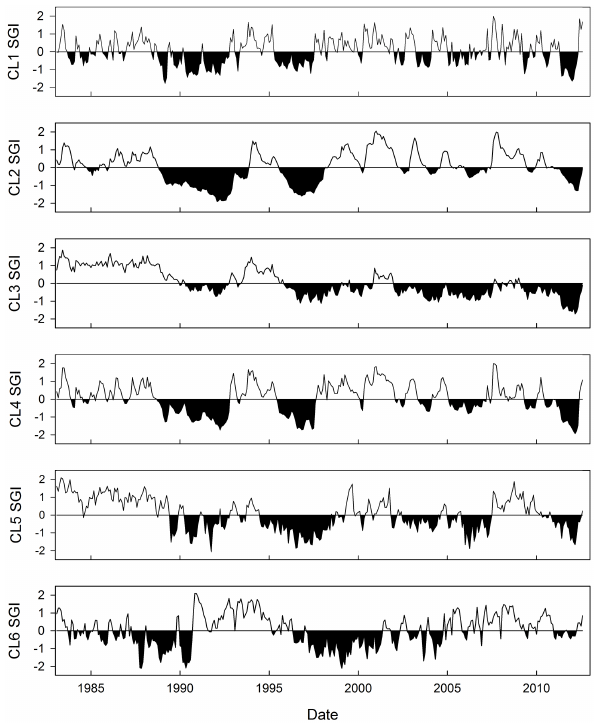
Figure 6. Mean SPI times series for each of the k -means clusters based on the accumulation period q max for each cluster. The black line is SPI based on gridded precipitation series for sites in a given cluster and the red line is SPI for the mean rainfall across the whole study area based on the different aggregation periods, q max , for each cluster.